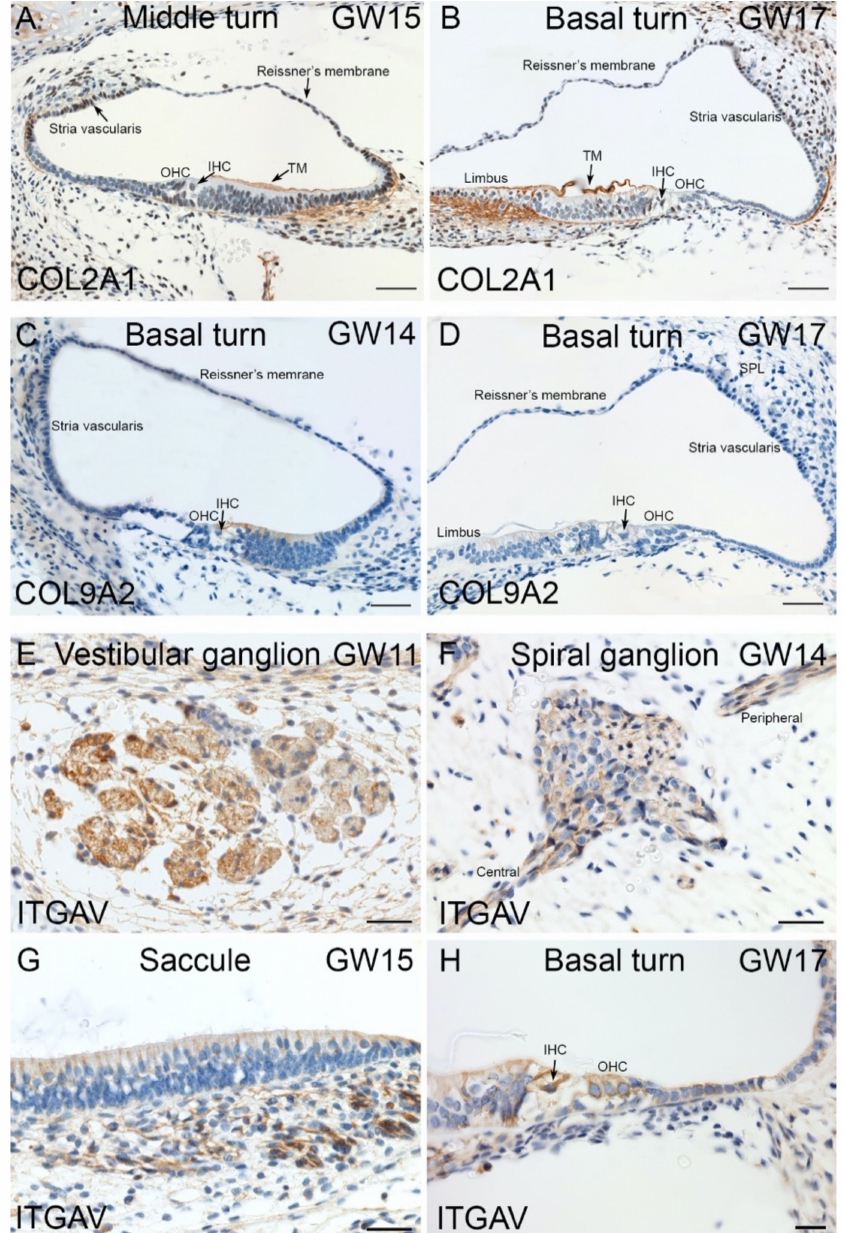
Figure 10. Immunostaining for ITGAV, COL2A and COL9A2 in human inner ear fetal tissue. ( A ) Collagen 2 alpha 1 expression present at GW15 in fibrocytes of the spiral limbus, the future tectorial membrane (TM) also in type I fibrocytes that underlie the stria vascularis region (arrow), Outer (OHC) and inner hair cells (IHC) are devoid of immunoreactivity. ( B ) Basal turn of cochlea at GW17. High expression of Collagen type 2 alpha 1 observed in fibrocytes of spiral limbus and